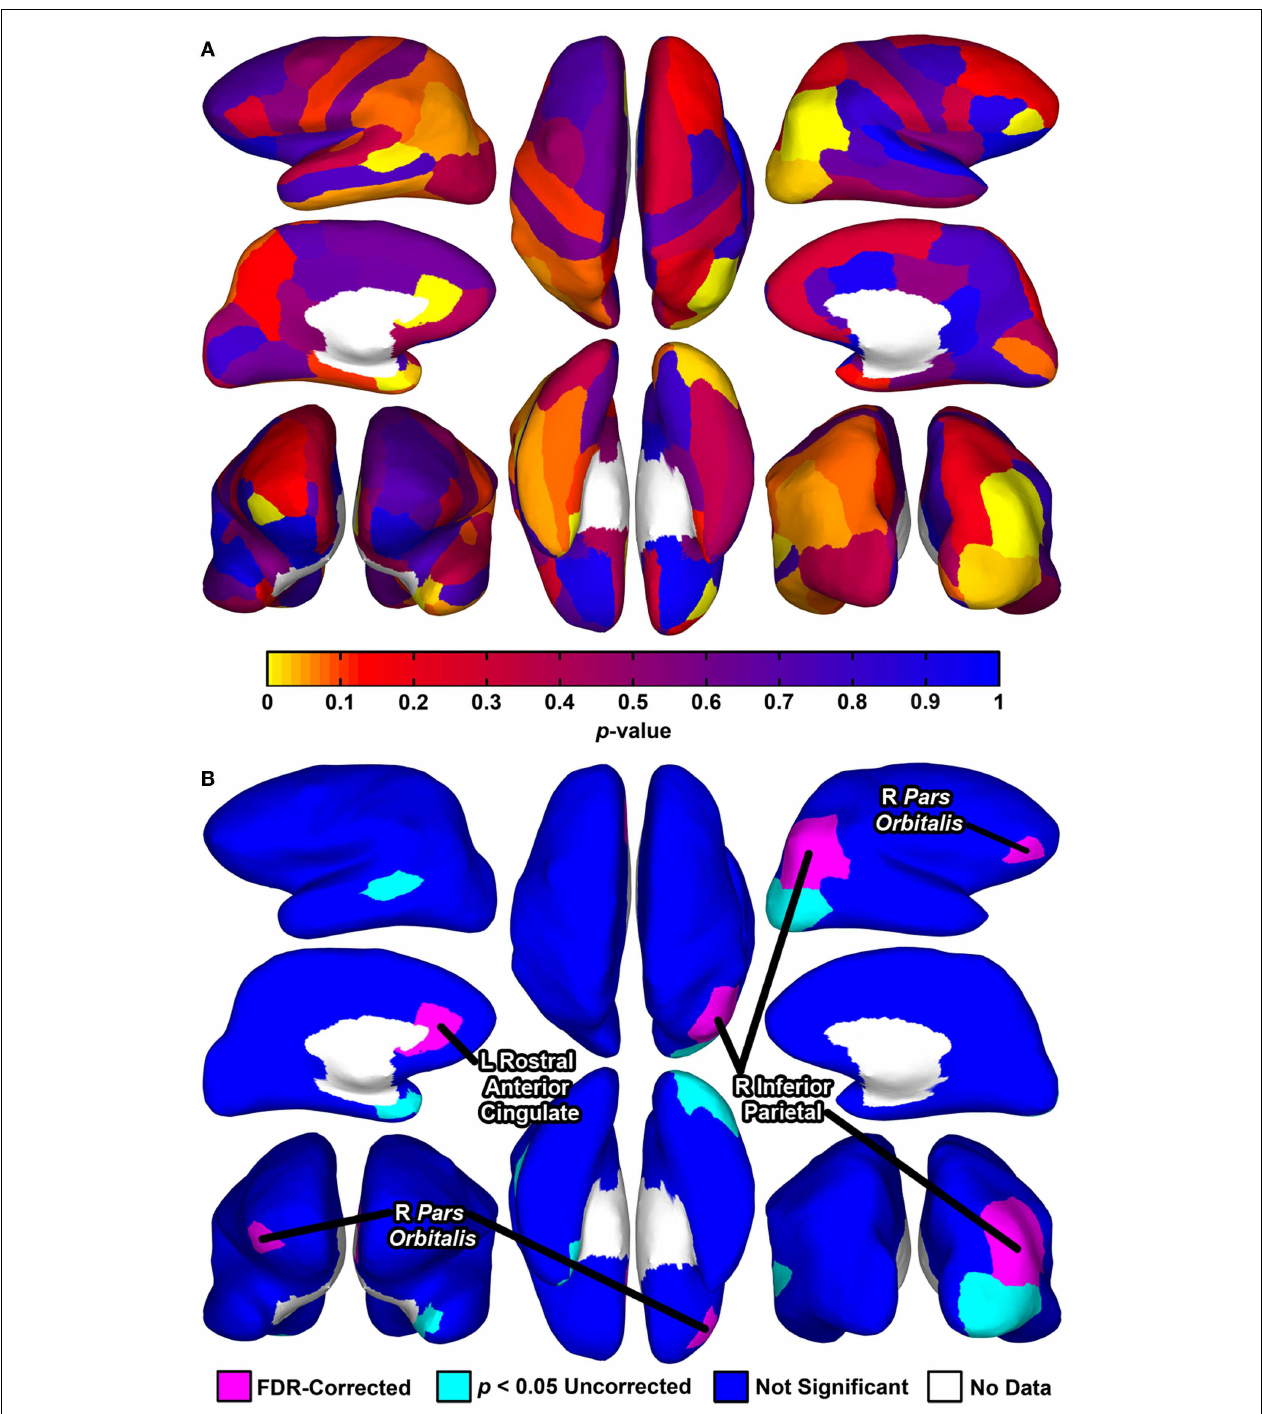
procedure (for means and SD, see Table 6 ). For (A,B) , upper left, left hemisphere lateral view; middle left, left hemisphere medial view; bottom left, bilateral anterior view (right hemisphere on left side); upper middle, bilateral superior view (left hemisphere on left side); bottom middle, bilateral inferior view (left hemisphere on left side); upper right, right hemisphere lateral view; middle right, right hemisphere medial view; bottom right, bilateral posterior